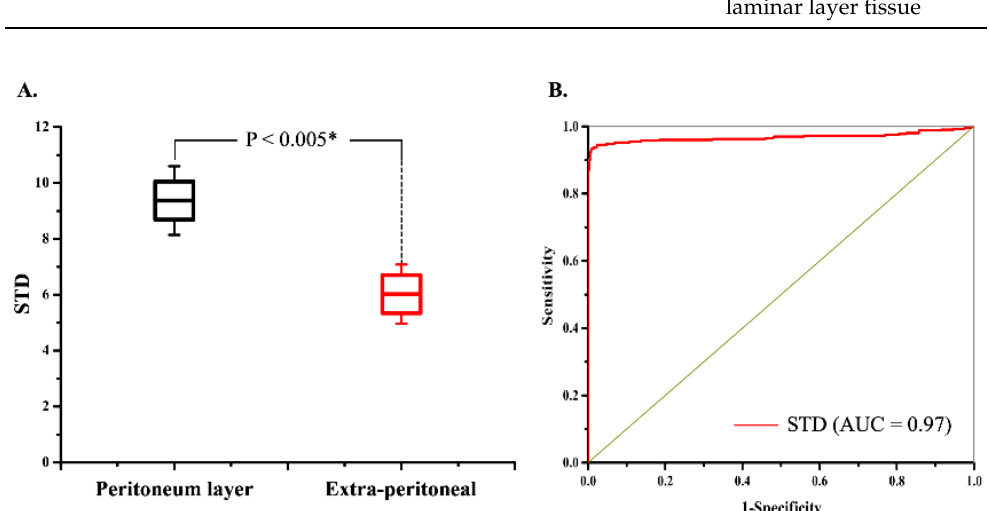
Figure 6. ( A ) Distributions of the OCT STD value from regions in the peritoneum and extra-peritoneal tissue. ( B ) Receiver operating characteristics (ROC) curves show the OCT STD value’s capacity for discrimination between the peritoneum and extra-peritoneal tissue. * p < 0.005. We created a 5 cm full-thickness lateral abdominal wall incision for the visual confir- mation of needle placement. The OCT images were significantly different before (Figure 7A) and after (Figure 7B) needle puncturing through the peritoneum. Figures 8 and 9 show serial OCT images of the puncturing process (left to right) while the incorporated Veress needle was punctured through the midline and paramedian abdominal regions. The tissues that the needle passed through were, in order: muscle, peritoneum, and intraperitoneal cavity. The needle’s outer and inner layers were scanned simultaneously after the needle passed through the muscle layer (or before puncturing through the fascia layer) and before puncturing through the